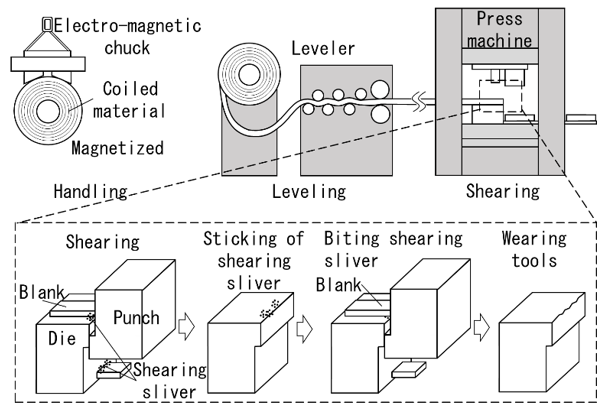
Figure 1. Auto body manufacturing process up to shearing.